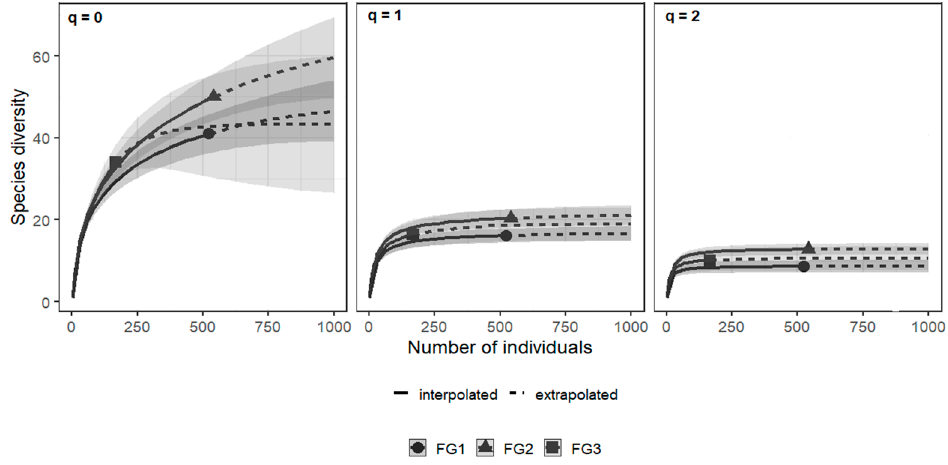
Figure 3. Individuals-based abundance rarefaction (solid lines) and extrapolation (dashed lines) of diversity based on the Hill numbers q = 0, q = 1, and q = 2 for three floristic group in Montane Forest. The 95% confidence intervals (gray-shaded regions) were obtained by a bootstrap method based on 50 replications. FG: floristic group.